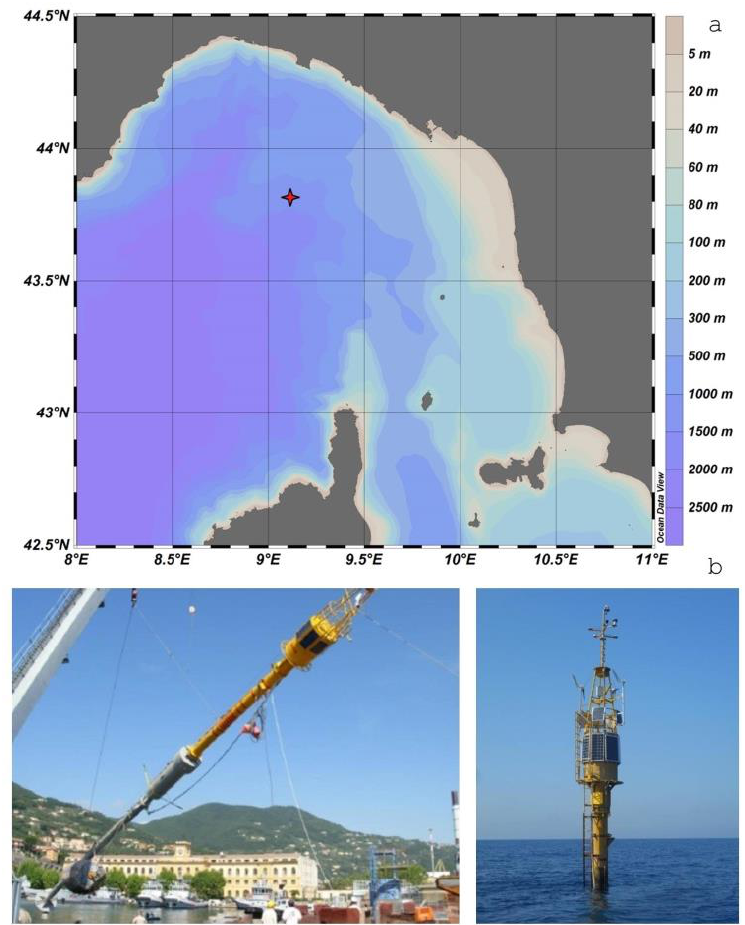
Figure 1. The spar buoy-mounted ADCP measurement station in the Ligurian Sea: ( a ) the W1-M3A observatory location, shown as a red four points star; ( b ) the buoy on land and in operation at sea. A three-beam ADCP, manufactured by Nortek (model Aquapro, [8]), was selected in order to avoid the possible interference of a fourth beam with the structure of the